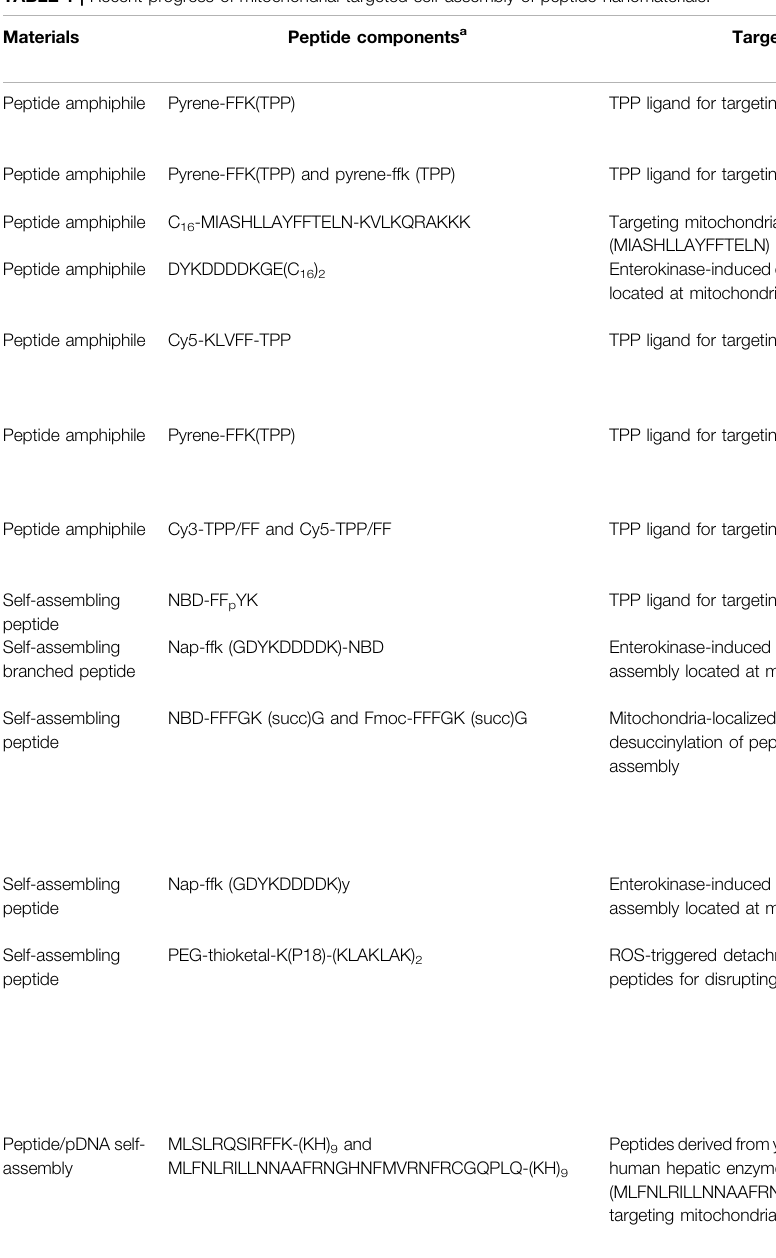
TABLE 1 | Recent progress of mitochondrial-targeted self-assembly of